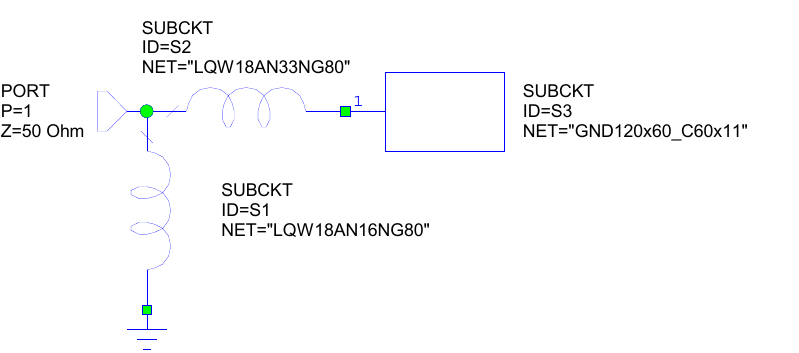
Figure 2. Result of the matching network with Murata’s commercial components. Inductors were SMD 0603 type with a Q > 85 at the 863–960 MHz frequency range. The series inductor was 33 nH, and the shunt inductor was 16 nH. The rectangle represents the impedance of the antenna booster on the 120 mm × 60 mm without any matching network.